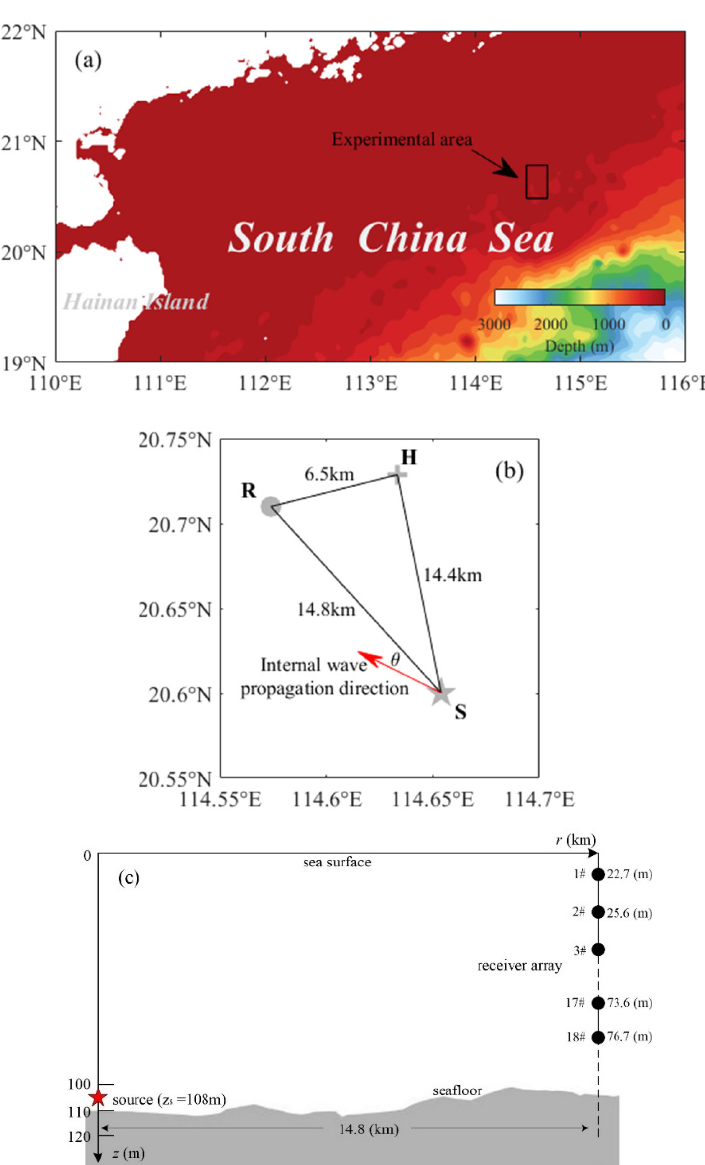
Figure 1. Acoustic experiment: ( a ) location of the experimental area and bathymetric contours, ( b ) geometry for the measurement positions of the deployed instruments (top view), ( c ) geometry for the positions of the acoustic source and VLA hydrophones (side view).